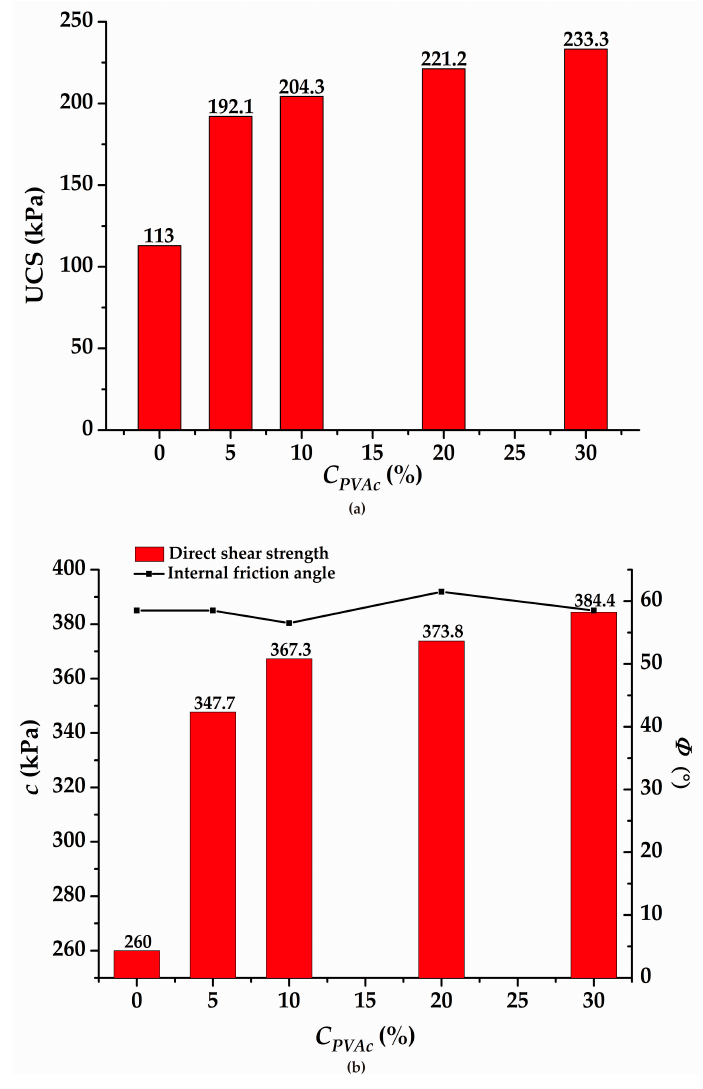
Figure 5. The variation of strength with C PVAc : ( a ) unconfined compressive strength (UCS) and ( b ) cohesion parameters.